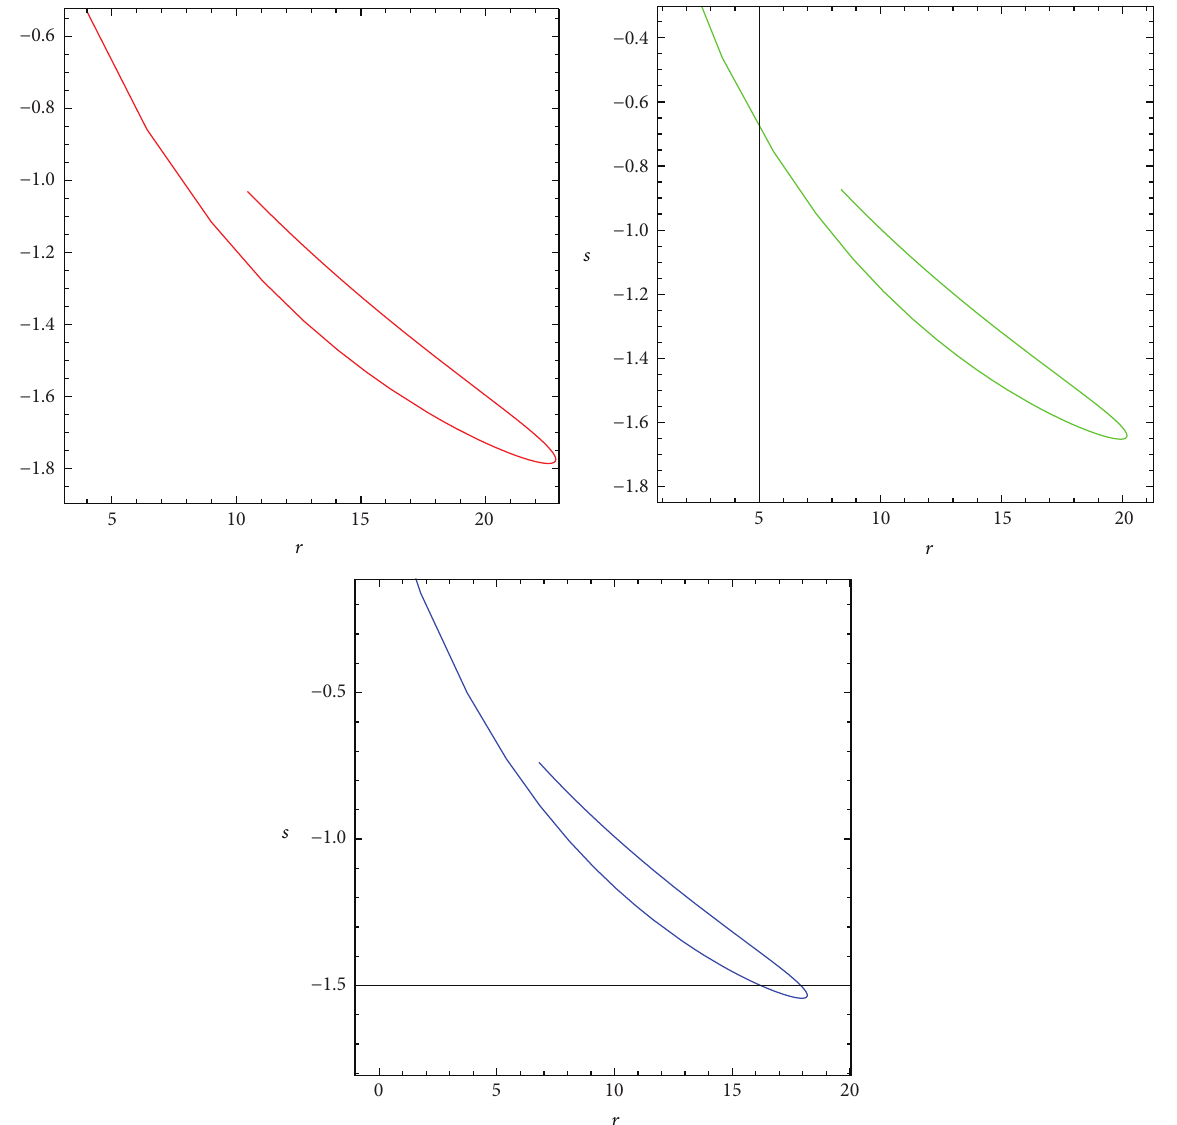
Figure 10: Trajectories of 𝑟 - 𝑠 for reconstructed PDE 𝑓(𝐺) model for 𝑢 = −2 with 𝑚 = 2 (red), 𝑚 = 2.2 (green), and 𝑚 = 2.4 (blue).